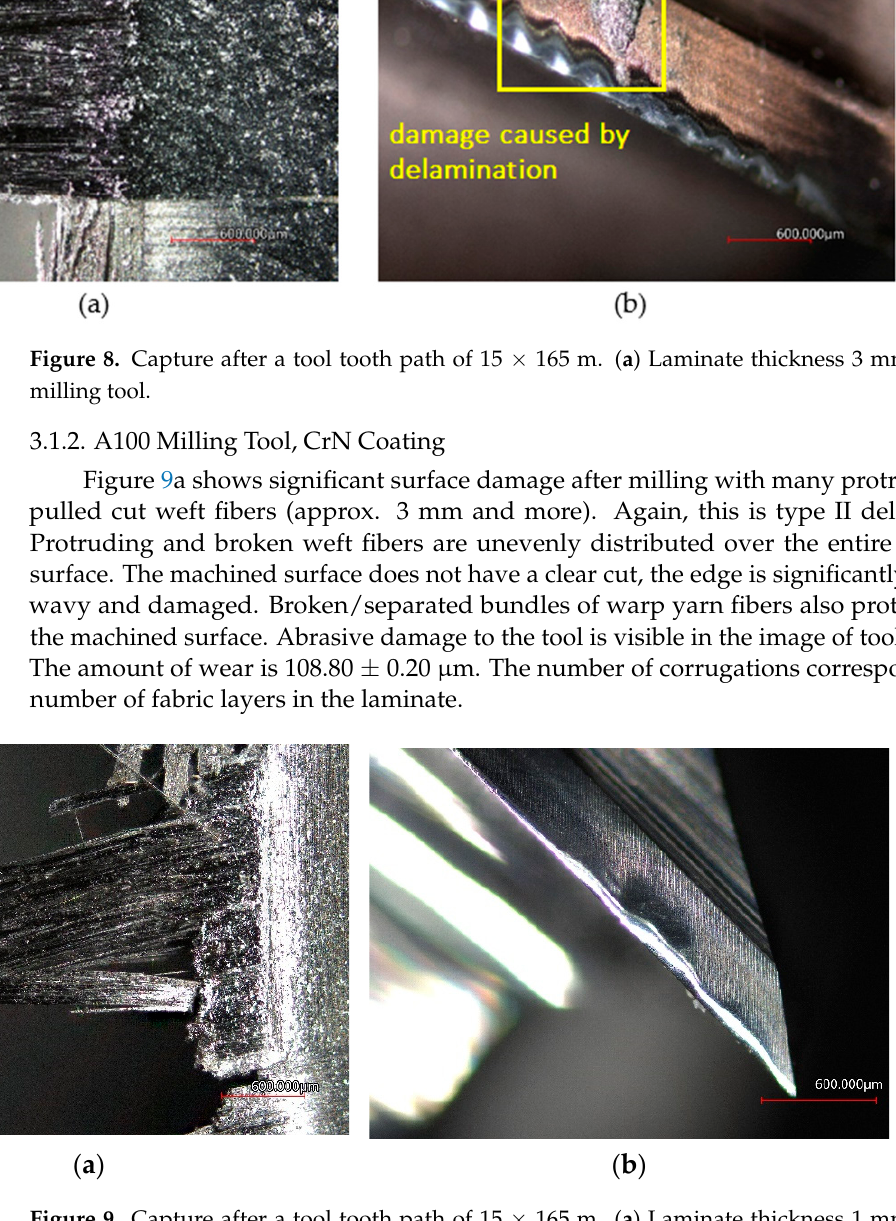
( b ) Figure 10. Capture after a tool tooth path of 15 × 165 m. ( a ) Laminate thickness 3 mm; ( b ) A100 milling tool. 3.1.3. ECSSF Milling Tool, DLC Coating In Figure 11a, a very fine layer of destroyed (broken) resin on the laminate is ob- served. The machined surface has a clear cut, and the edge is solid, without burrs and protruding fibers. In some places of the machined surface, slightly protruding bent bun- dles of warp yarn fibers were rarely seen. In Figure 11b, the measured value of the tool coating wear can be observed, which is 284.550 µm due to the abrasive effects of the car- bon fiber. Figure 11b of the tool indicates abrasive damage to the tool. The resulting wear rate of the tool base material was 74.70 ± 0.16 µm after the tool tooth path 15 × 165 m.